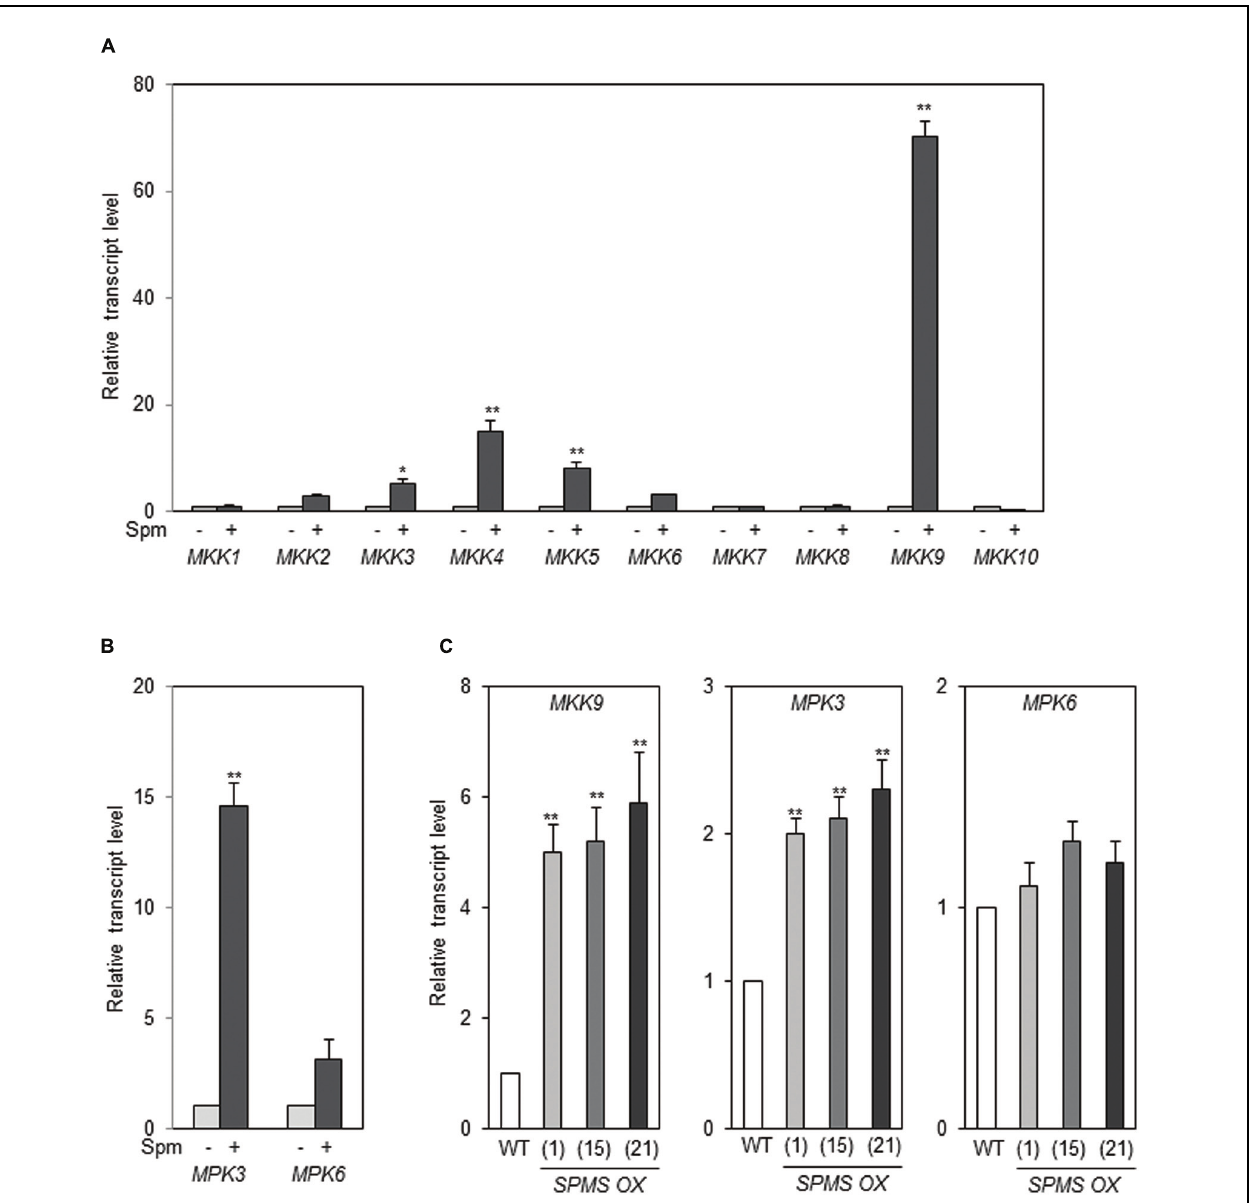
FIGURE 7 | Spm upregulates MKK9, MPK3, and MPK6 . (A) Exogenous Spm upregulated MKK9 among 10 MKK s. (B) Exogenous Spm upregulated MPK3 and MPK6 . (C) The transcript levels of MKK9 , MPK3, and MPK6 in the SPMS_OX transgenic lines. The levels of MKK9 , MPK3, and MPK6 transcripts were quantitatively determined by qRT-PCR using the primer pairs listed in Supplementary Data Sheet S1. Values are mean ( ± SD) from three independent experiments. Asterisks indicate significant difference ( ∗ P < 0.05 and ∗∗ P <